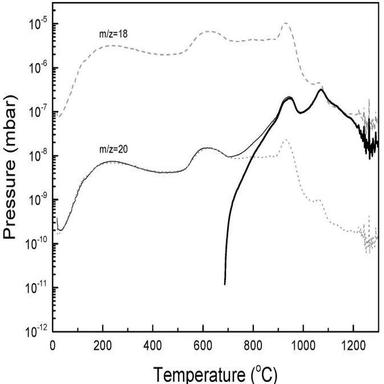
Derivation of HF signature (thick solid line) by subtracting the isotopic H2 18O contribution (dotted line) scaled from the m/z = 18 water peak (dashed line). The data were truncated at ~700 ◦C. The H2 18O correction is negligible above ~900 ◦C.